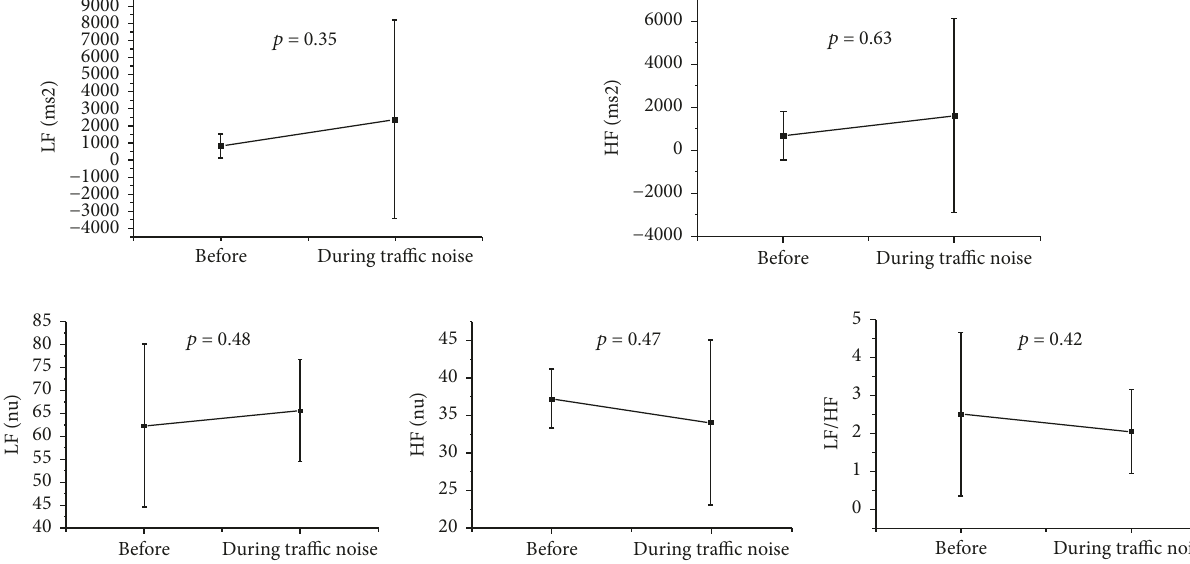
Figure4:HRVanalysisbefore(control)andduringtrafficnoiseexposure.LF:lowfrequency;HF:highfrequency;LF/HF:lowfrequency/high frequency ratio; n.u.: normalized units; ms: milliseconds; HR: heart rate; 𝑝 : level of